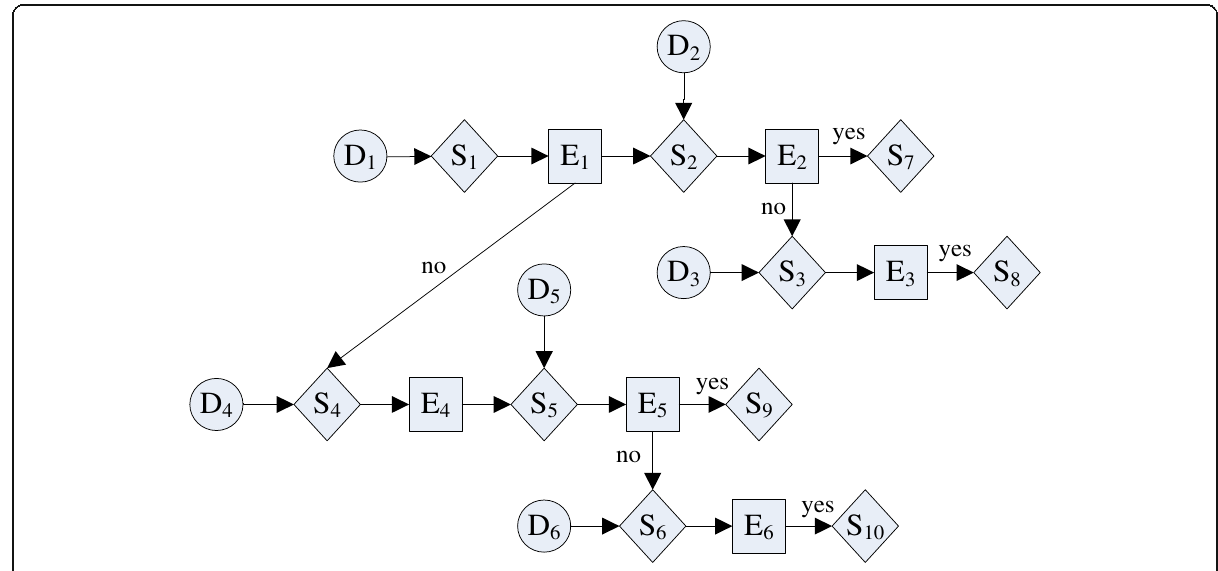
Fig. 6 The evolution path of the Gulf of Mexico oil